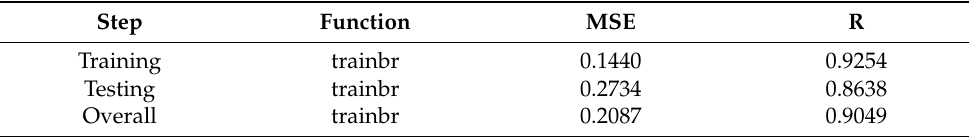
Figure 10. BR model error histogram. Table 5. Summary of different model evaluation parameters of